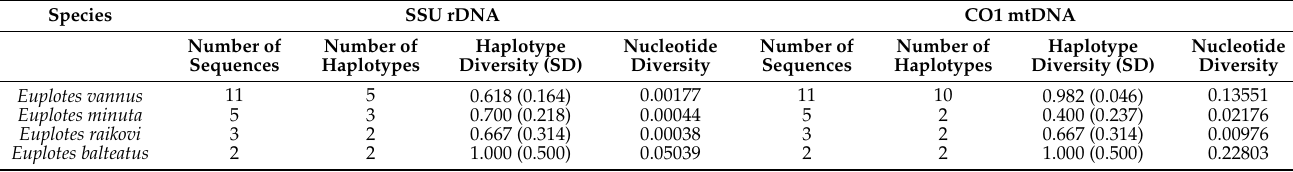
Table 3. Variability of the SSU rDNA and CO1 fragments in four species of Euplotes with more than two isolates each. Species